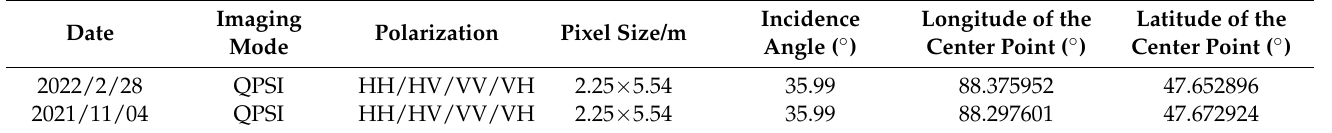
Table 1. The Gf-3 image information.